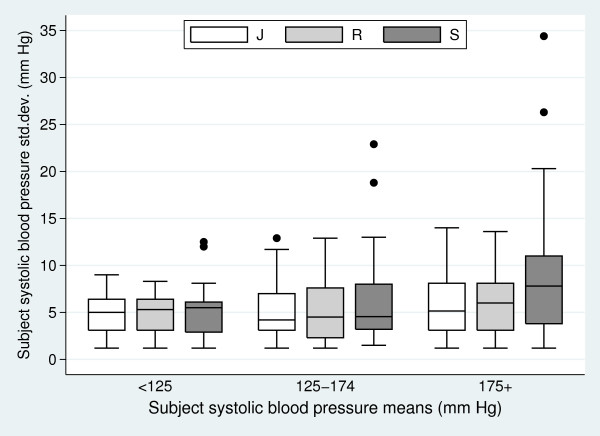
Box-plot of the subject's systolic blood pressure measurement standard
deviations by their mean systolic blood pressure measurements grouped into
three categories (< 125 mm Hg, 125–174 mm Hg, and 175+ mm Hg) for
the two observers (J and R) and the automated machine (S).